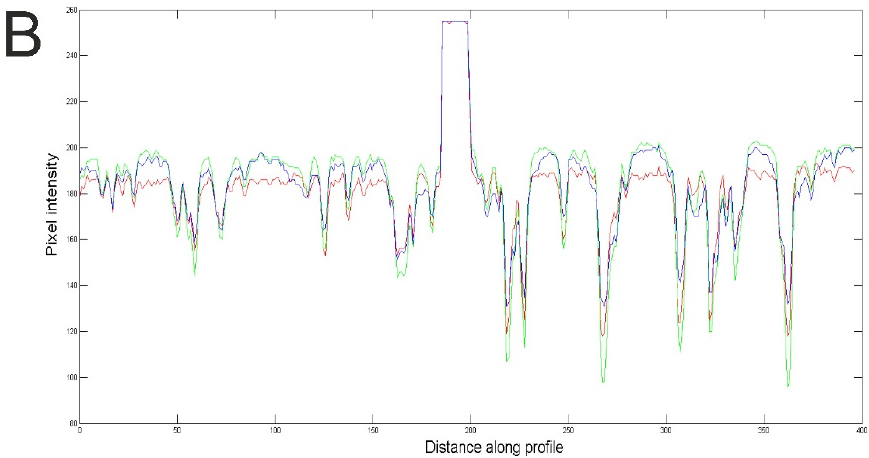
Figure 3. Impact of iron nano particles. ( A ) Optical micrographs of the gold surface before and after magnetic signal amplification; ( B ) Pixel intensity changes along the red reference line for red, green, and blue colors.